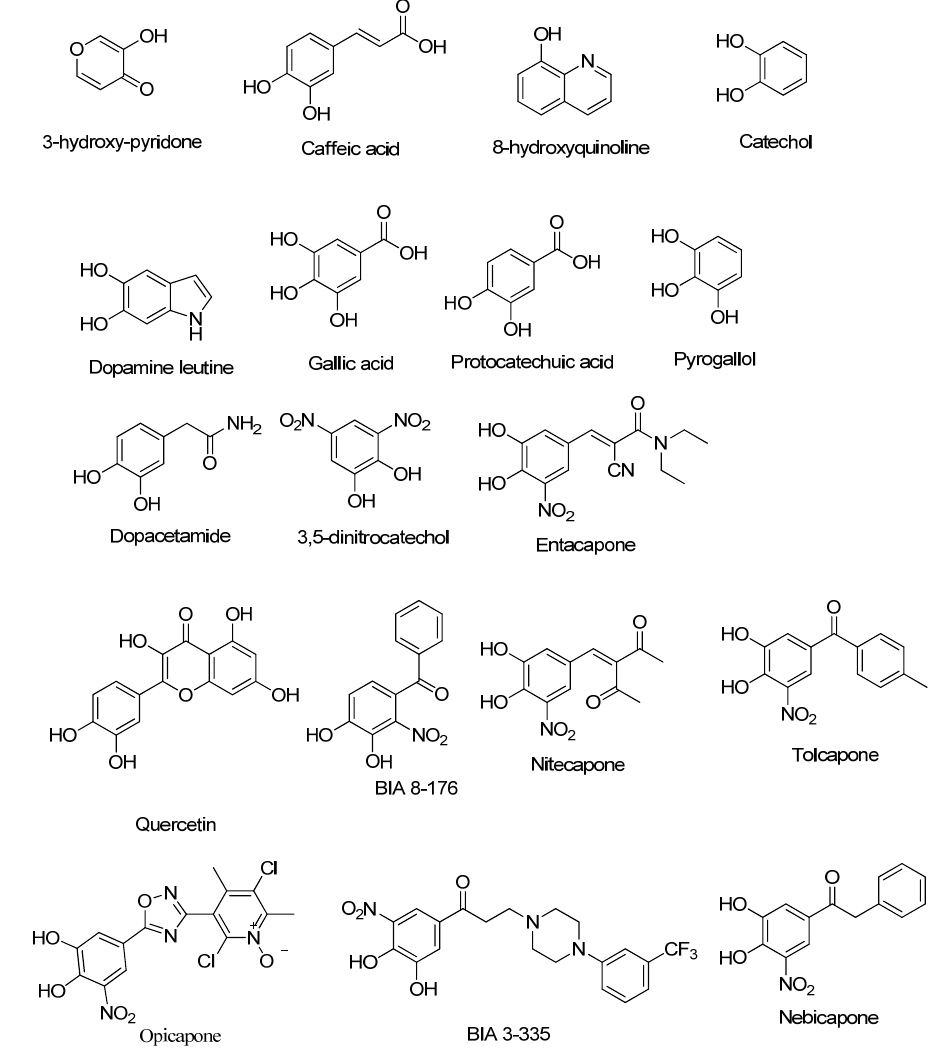
Figure 1. 2D structures of the selected COMT inhibitor training set.